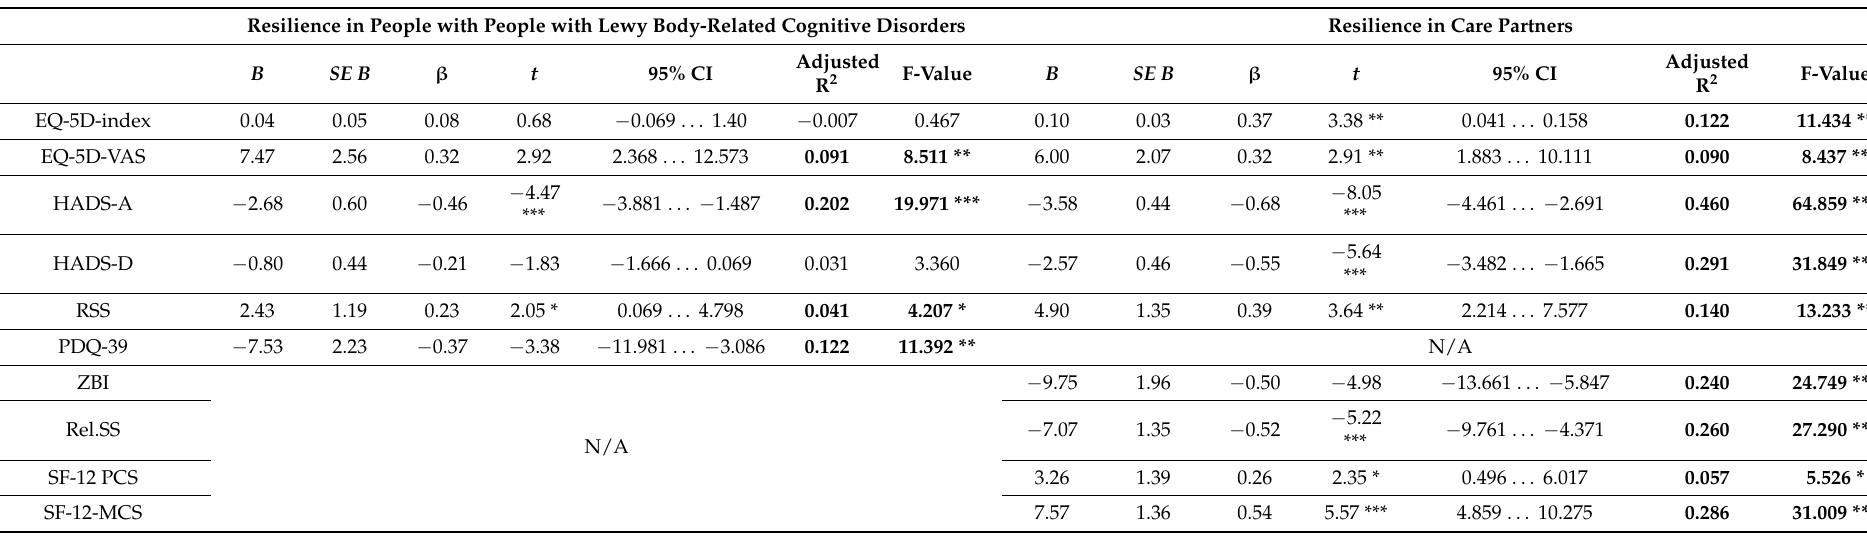
Table 6. Linear regression analyses of resilience and key outcomes in people with Lewy body-related cognitive disorders and care partners and care partners. Resilience in People with People with Lewy Body-Related Cognitive Disorders Resilience in Care